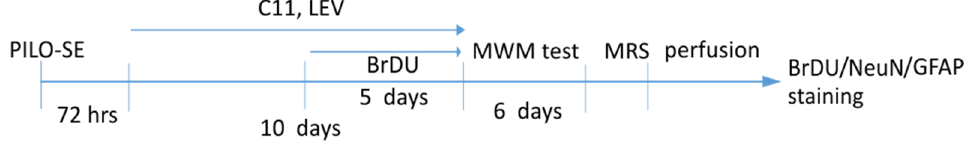
Figure 5. Experimental study design.